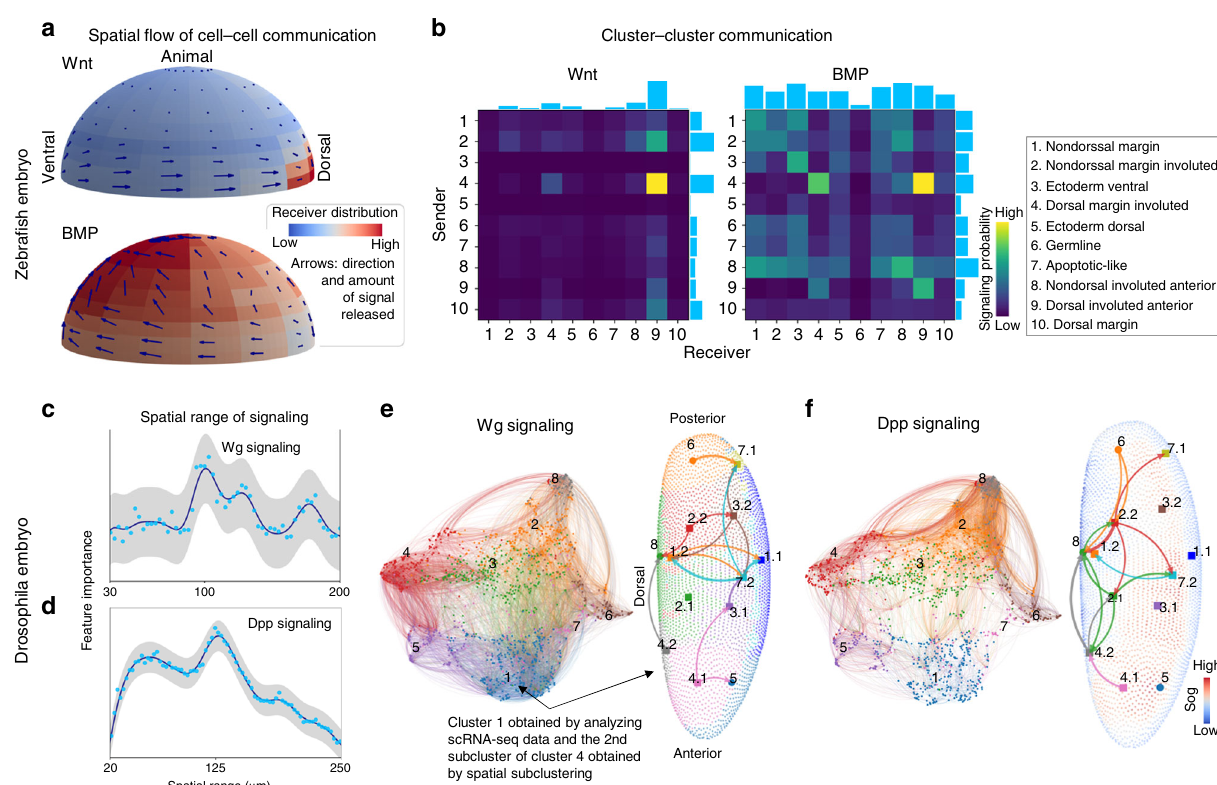
Fig. 4 Reconstruction of cell – cell communications in space. a (zebra fi sh embryo) Wnt and BMP signalings interpolated from the SpaOTsc cell – cell communication matrix and mapped to space using the mapping between cells and positions. The arrow lengths indicate the signal sending probability of the position and the color shows the estimated signal receiver probability distribution over space. The scRNA-seq data from ref. 36 and spatial data from ref. 13 were used. b (zebra fi sh embryo) Wnt and BMP signaling summarized into cell clusters. c, d ( Drosophila embryo) Spatial ranges of Wg and Dpp signaling inferred using a series of sets of random forest models. The gray band represents the 95% con fi dence interval. The experiment was repeated three time with similar results. e ( Drosophila embryo) Left: cell – cell communications of Wg signaling at the single-cell level using a visualization (UMAP) constrained by cell – cell distance. The color of the link is marked by the color of the sending cells, based on the clustering using only scRNA-seq data. Right: cluster – cluster communications of Wg signaling based on SpaOTsc spatial subclustering (subcluster the previously determined clusters based only on scRNA-seq data using the cell – cell distance). f ( Drosophila embryo) Dpp signaling in space plotted similar to ( e